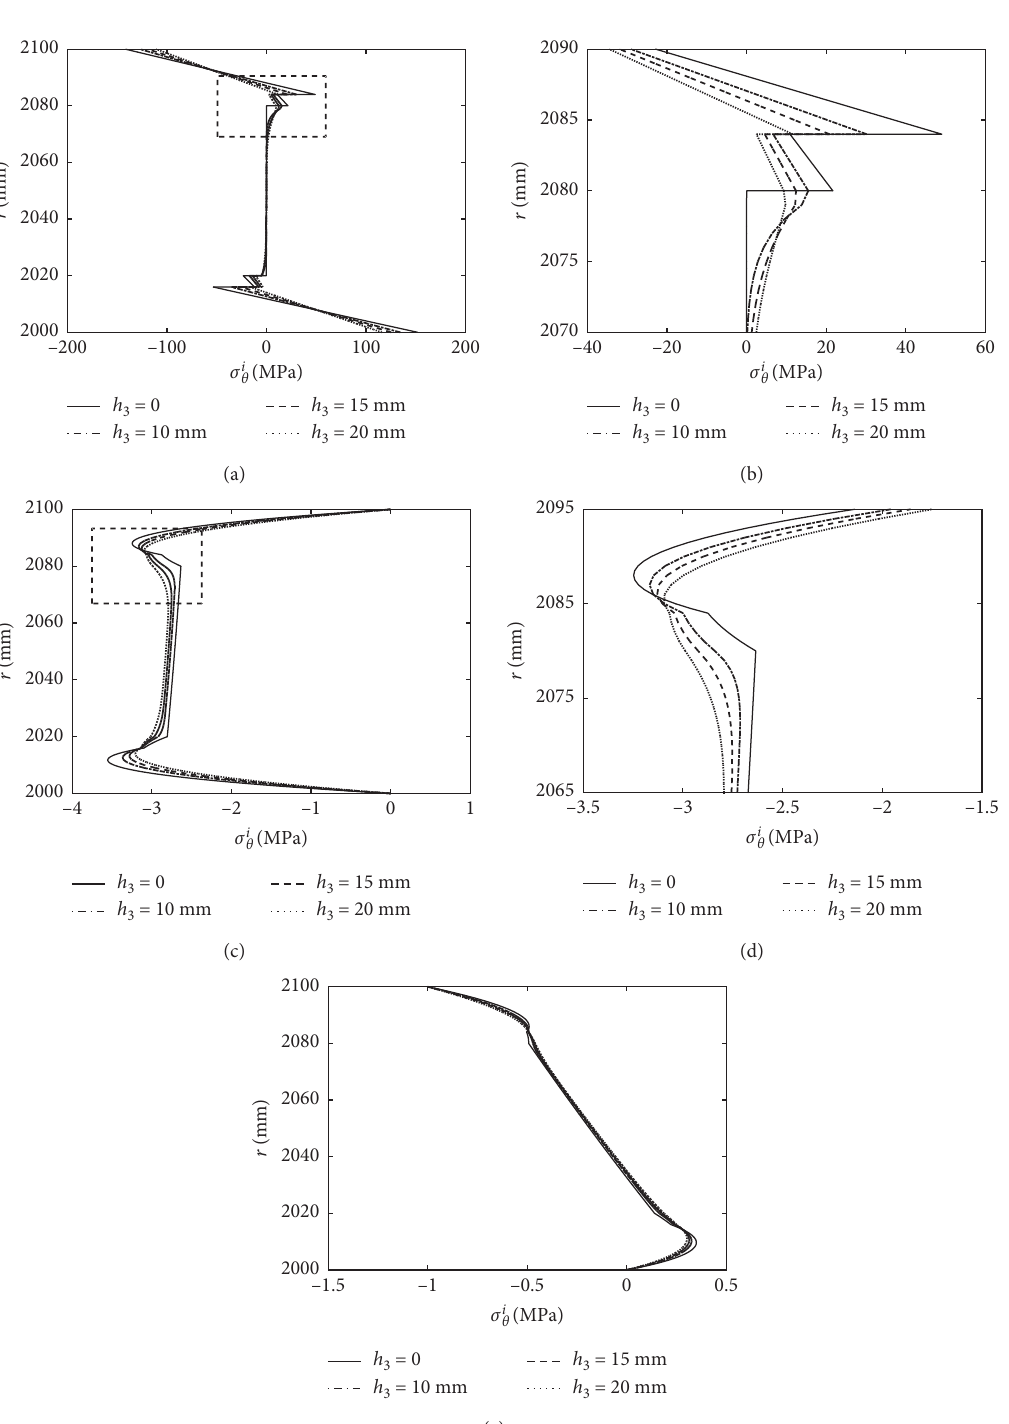
� 0, 10, 15, and 20mm, respectively. (a) σ i 3 . (e) σ i r at θ � r θ